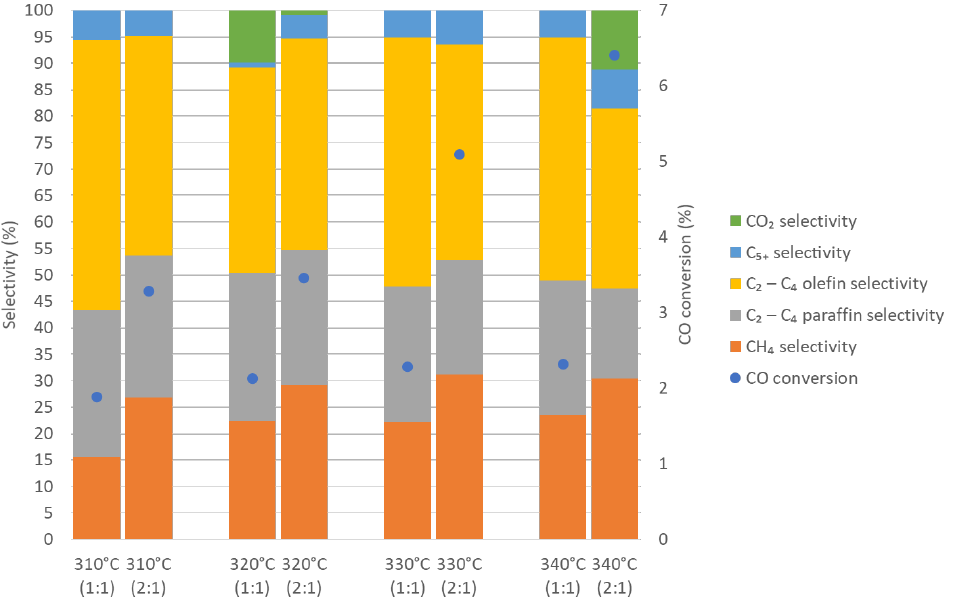
Figure 6. CO conversion and selectivities as a function of temperature and H 2 /CO 2 ratio. GHSV: 2250 h − 1 .